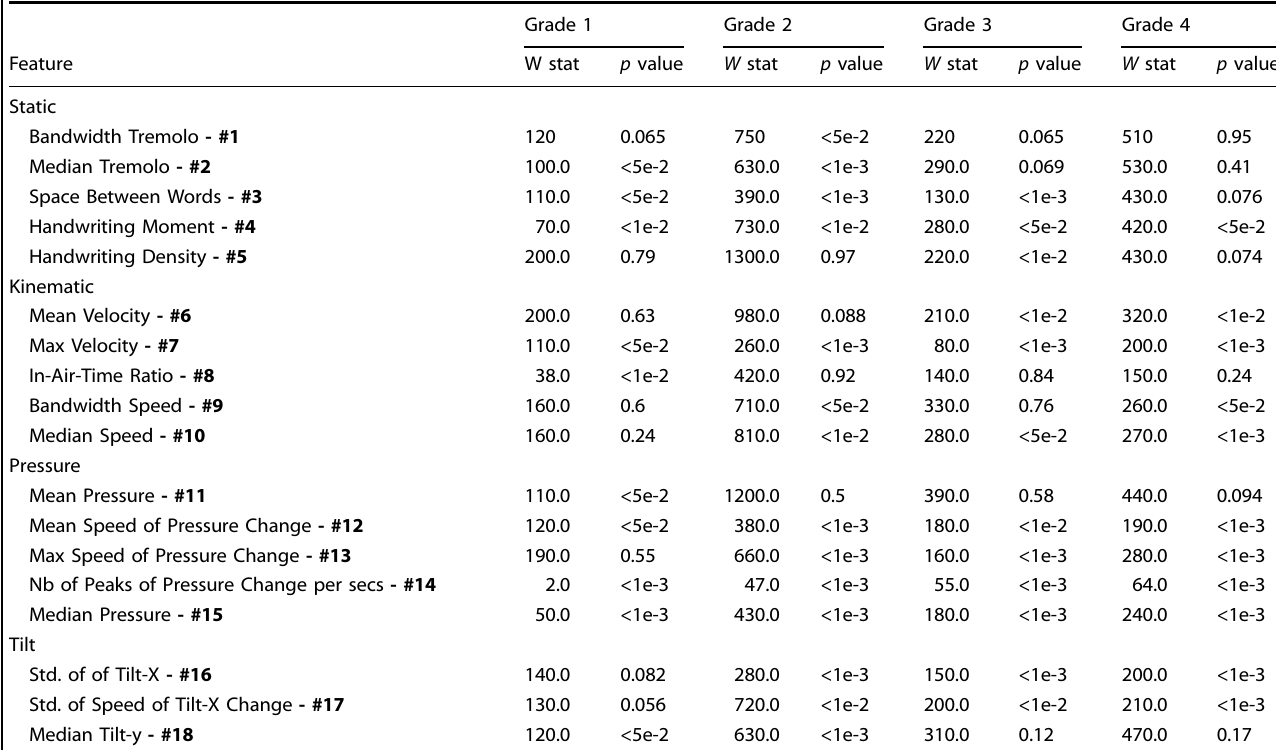
Table 1. Feature differences between the two alphabets (Cyrillic and Latin) across